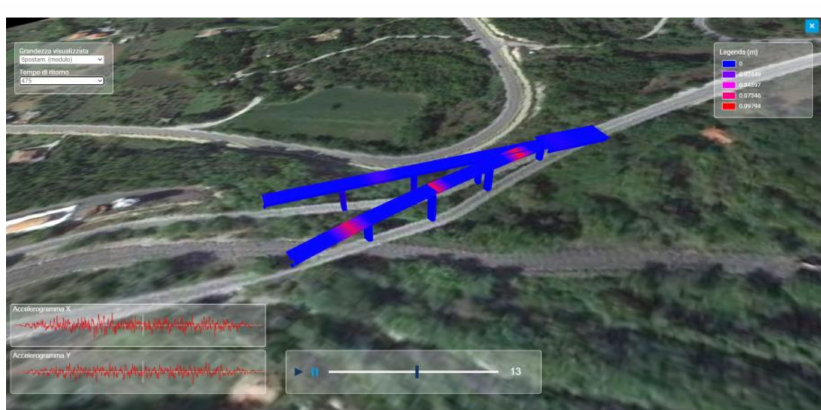
Figure 13. Render three-dimensional